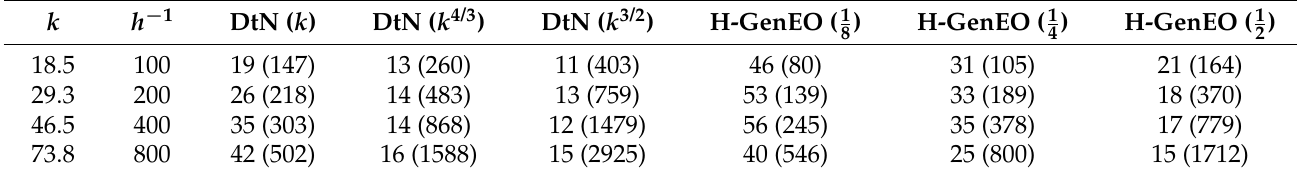
Table 2. Preconditioned GMRES iteration counts and size of coarse space (in parentheses) for the homogeneous problem when using ORAS and the DtN and H-GenEO coarse spaces with varying eigenvalue thresholds. A uniform decomposition into 5 × 5 square subdomains is used, giving 25 subdomains in total.